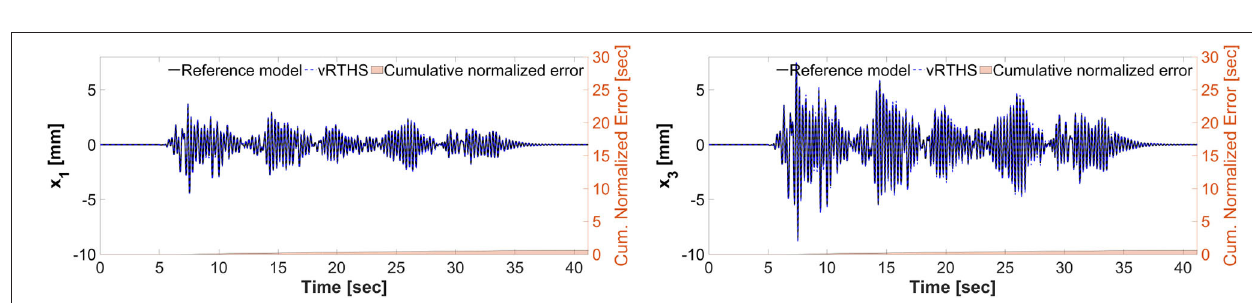
before and after the damage occurrence. However, in an RTHS experiment neither will be available before the test